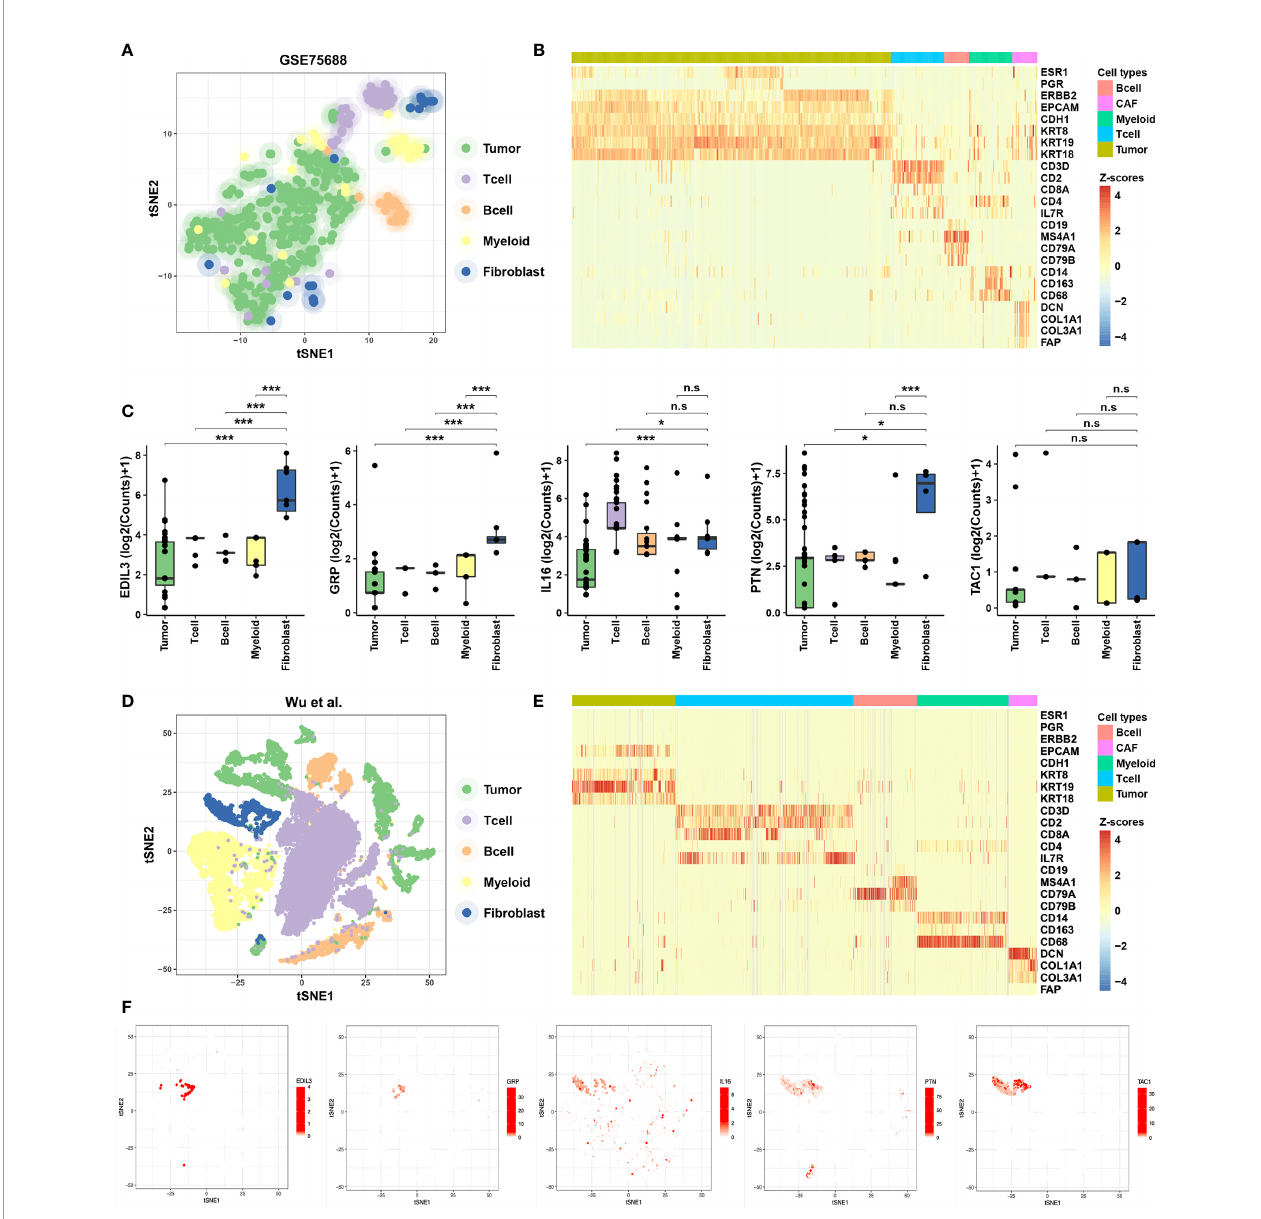
FIGURE 2 | Identi fi cation of the speci fi city for the fi ve cytokines in ScRNA-Seq data of BC. (A) Cellular populations identi fi ed in the GSE75688 dataset, and the tSNE projection of 565 cells showed the clusters with label names. Each dot corresponds to a single cell, colored according to cell type. (B) Heatmap of marker gene sets among tumor cells, T cells, B cells, Myeloid cells, and fi broblasts of GSE75688 dataset. (C) Comparisons on average expression of the fi ve CAF-related cytokines. Bar, median; box, 25th to 75th percentiles (interquartile range, IQR); vertical line, data within 1.5 times the IQR. ***FDR < 0.001 and *FDR < 0.1. n.s., non- signi fi cant. (D, E) Clustering of 24,271 cells from the other ScRNA-Seq data of BC (see Methods ) using tSNE method (D) , and the heatmap showed marker gene sets among different cell types (E) . (F) The fi ve CAF-related cytokines were labeled in clusters by cell identity as represented in the tSNE